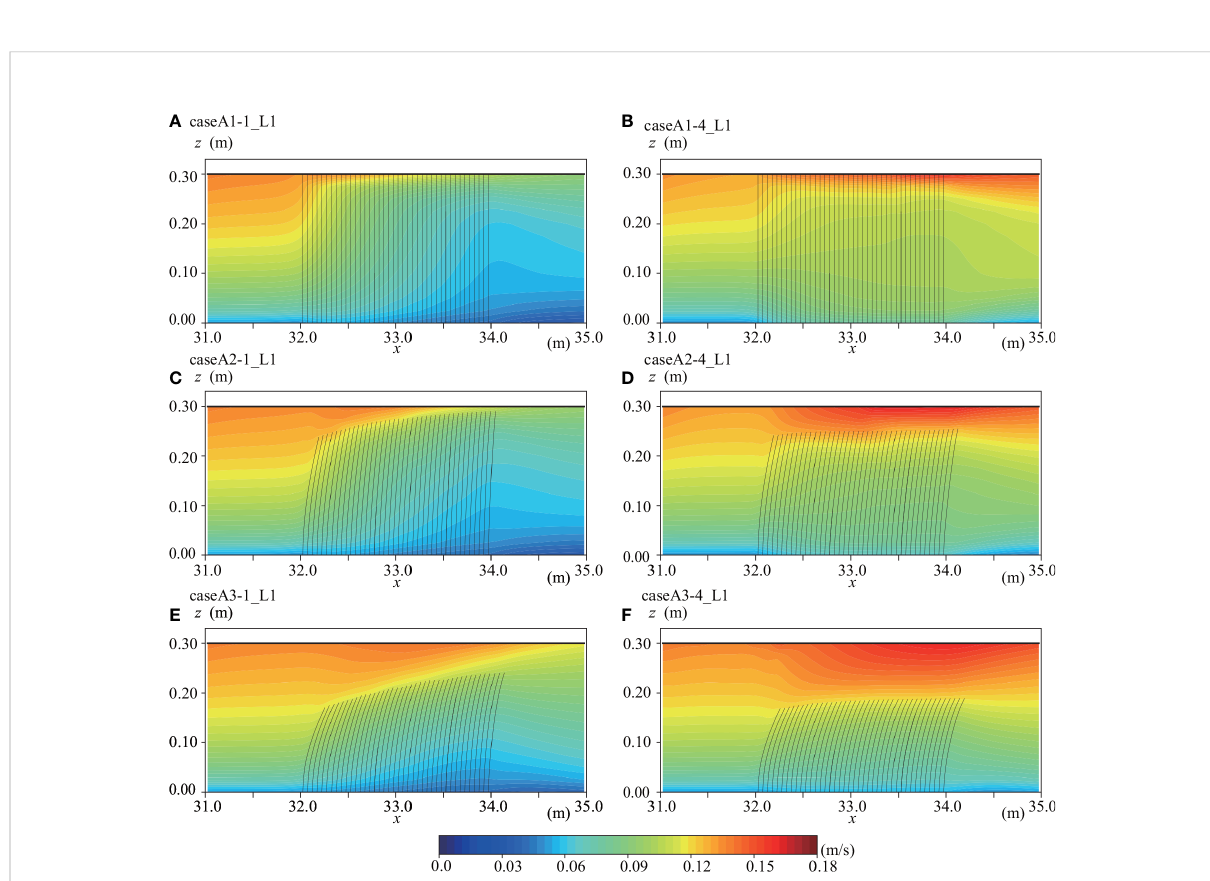
FIGURE 6 Horizontal velocity distributions at L1 in (A) case A1-1, (B) case A1-4, (C) case A2-1, (D) case A2-4, (E) case A3-1, and (F) case